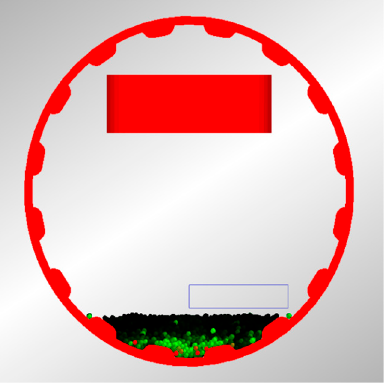
Figure 5. Model of the roller.